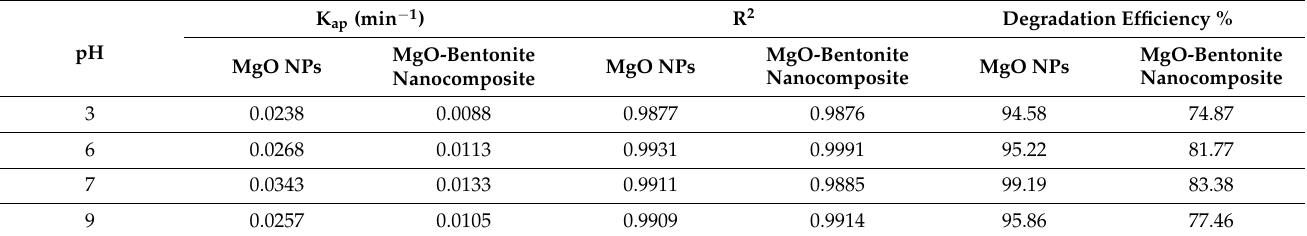
Figure 10. Effect of different pH values on the photocatalytic degradation of CV using MgO NPs and MgO/Ben nanocomposite. Table 3. Apparent pseudo-first-order rate constants, K ap (min − 1 ), of degradation of crystal violet by MgO NPs and MgO/Ben nanocomposite at different pH values.